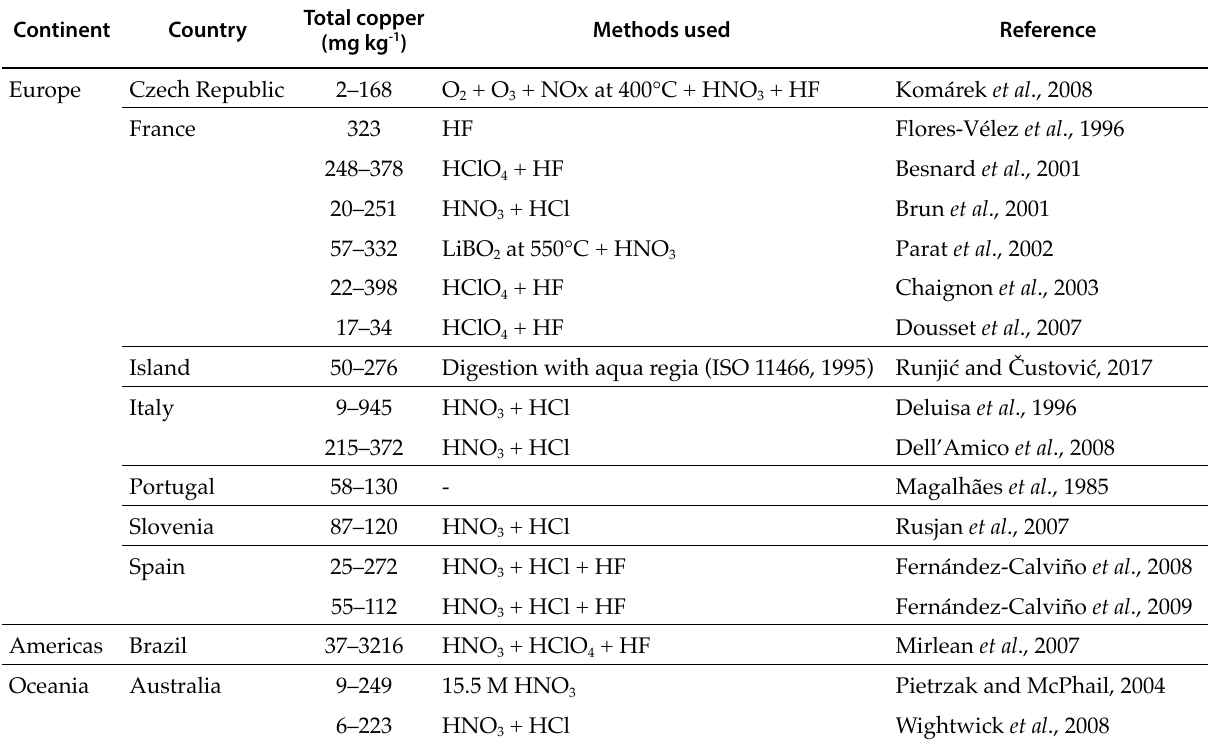
Table 1. Total copper concentrations reported in vineyard topsoils (data from Komárek et al ., 2010; Mackie et al .,